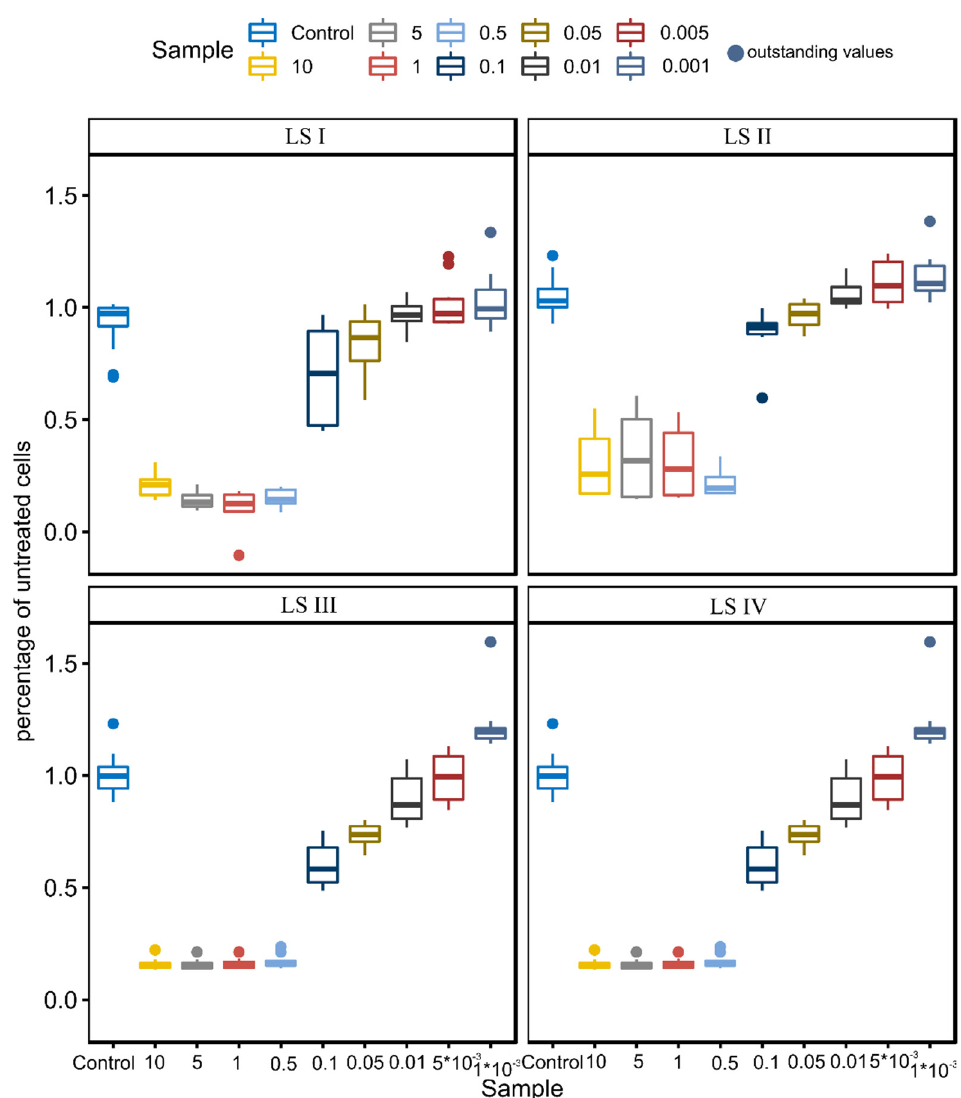
Figure 2. AlamarBlue™ assay of tested soaps ((LS I − base; in following soaps addition of 4% ( w/w ) surfactants: LS II − cocamidopropyl betaine; LS III − addition of cocamidopropyl hydroxysultaine; LS